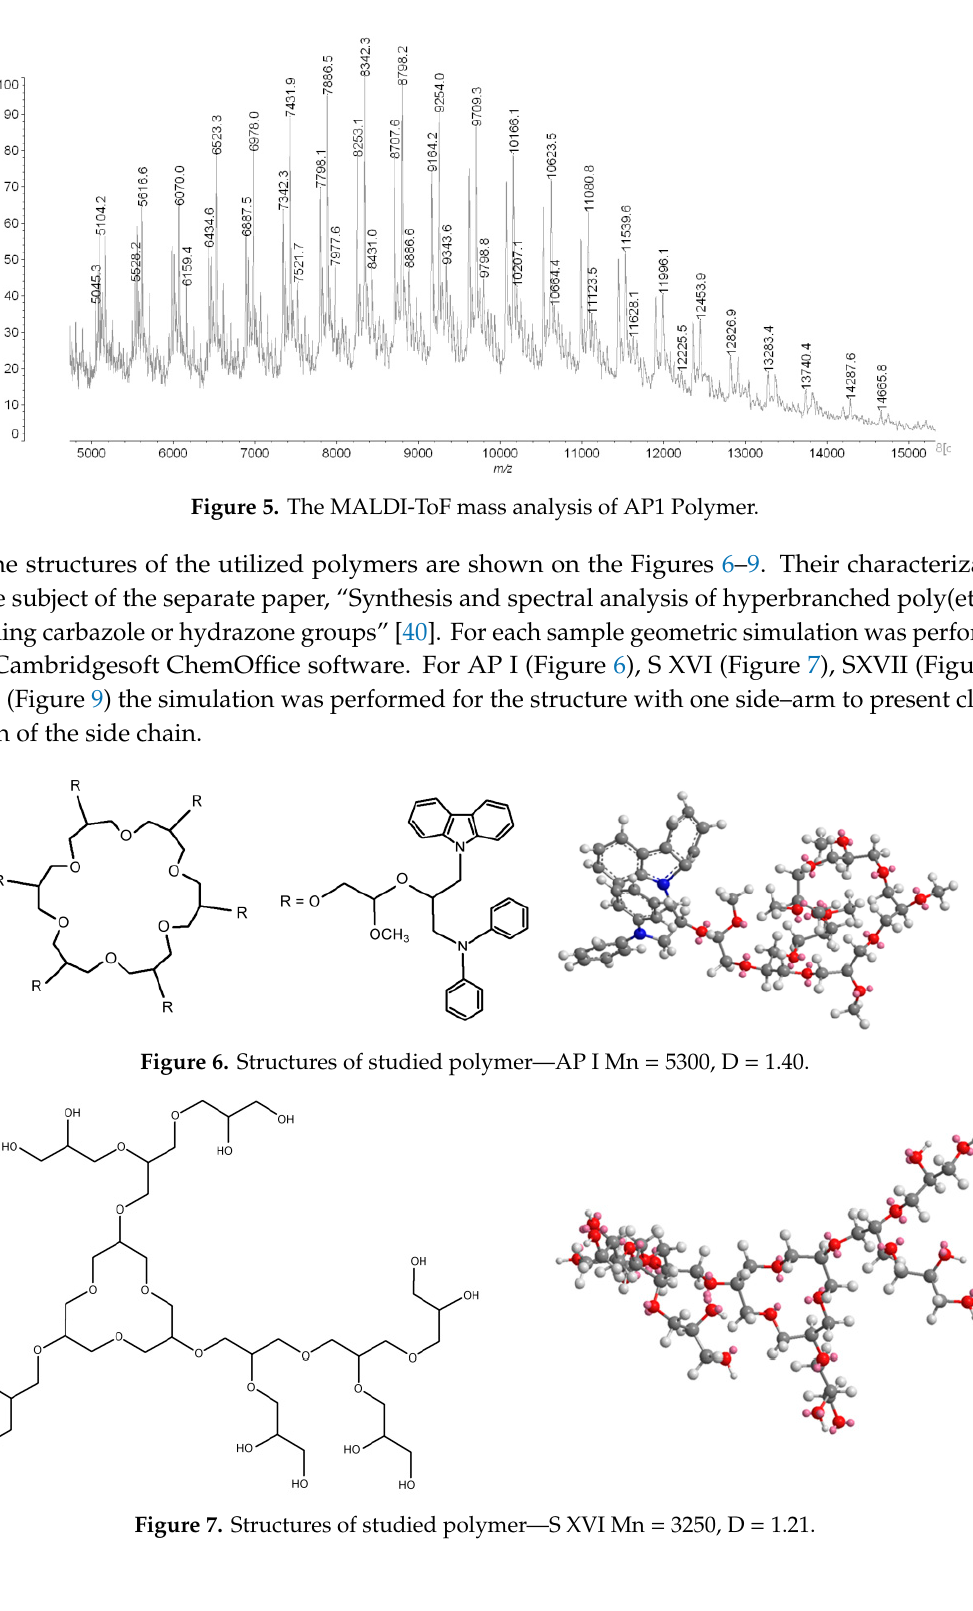
Figure 4. Simplified scheme macromolecule with two branches (* means places of chain growth).